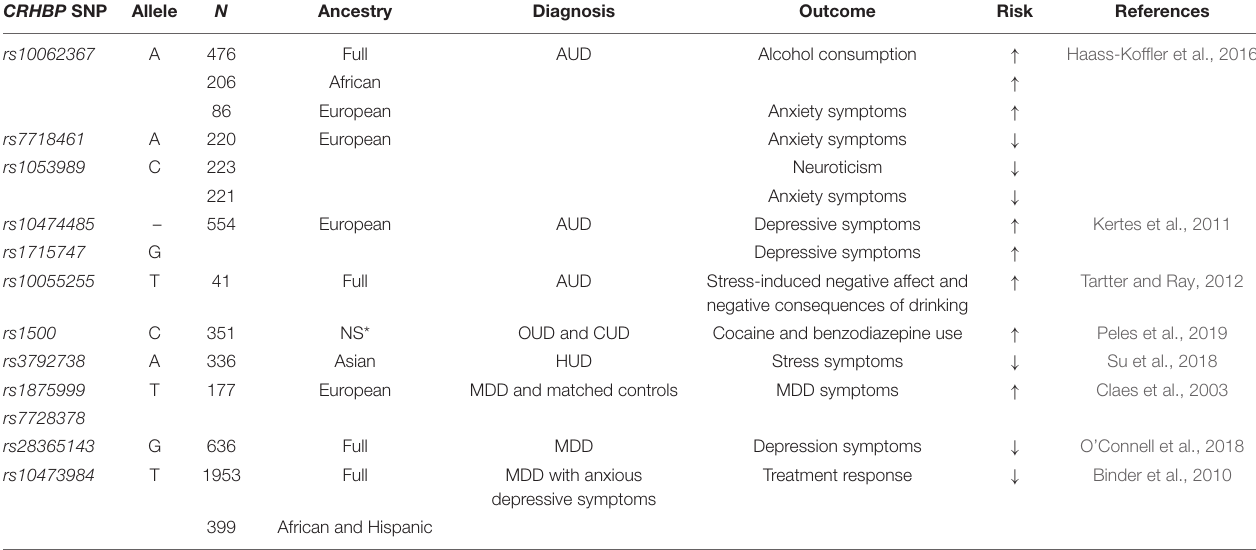
TABLE 1 | Association between single nucleotide polymorphisms (SNPs) of the CRHBP gene, psychiatric and neurodegenerative disorders. CRHBP SNP Allele N